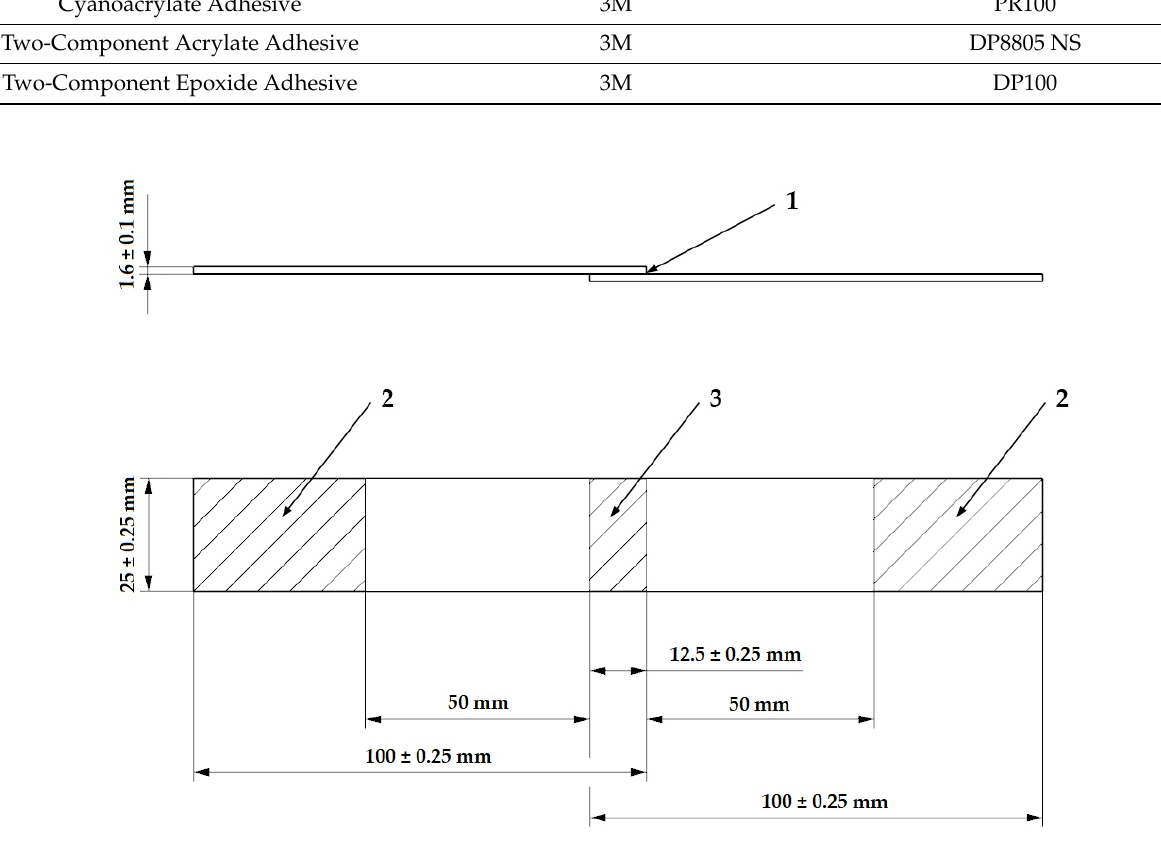
Figure 2. Bonded joint: (1) adhesive layer, (2) area of test machine grips, and (3) shear area [32].